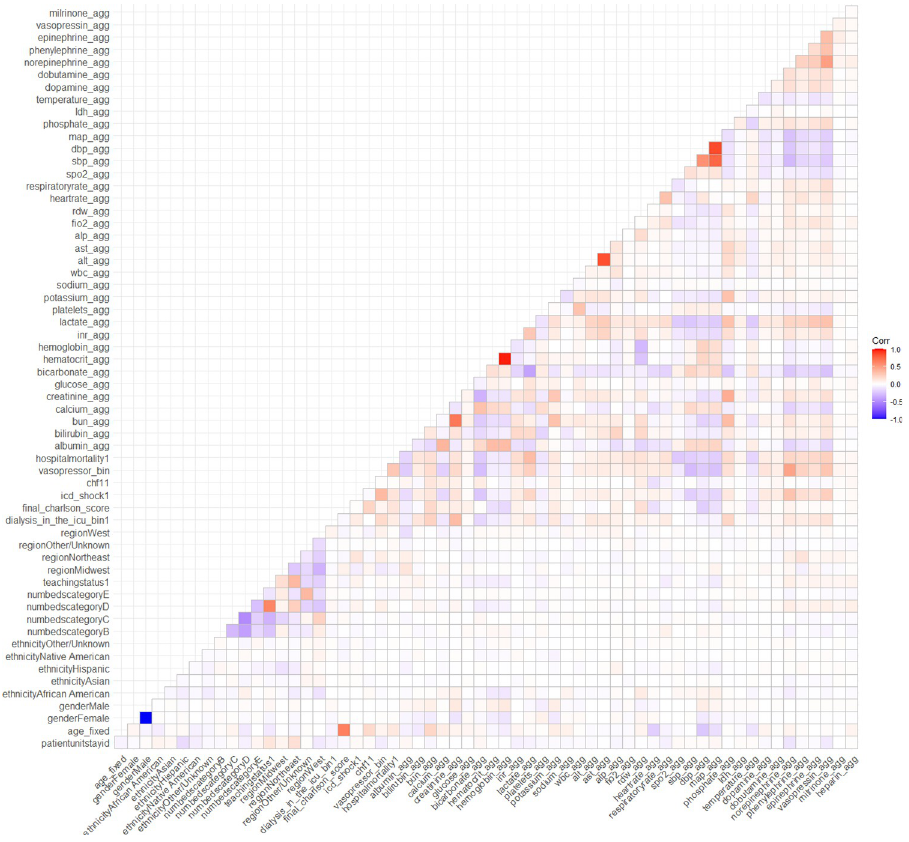
Fig 3. The correlation plot for the variables in the high resolution